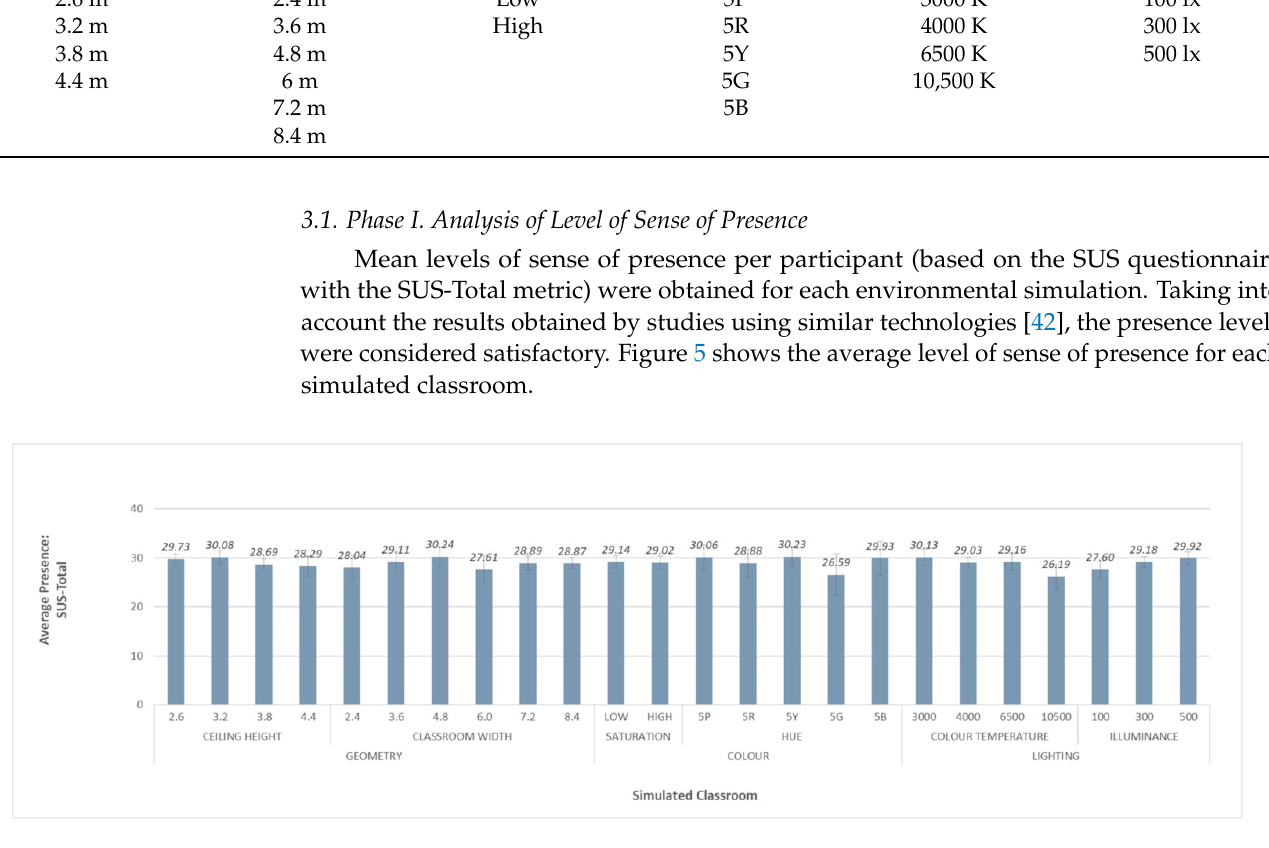
Figure 6. Standardised means of the psychological memory task for women, Memory-Correct Responses for women. 3.2.1. Effect of Variations in Classroom Shape (Ceiling Height and Classroom Width)